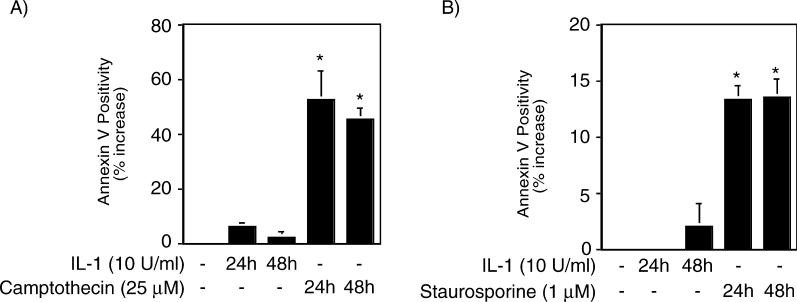
Effects of IL-1 on Annexin V Staining in RINm5F Cells and Rat IsletsTreatment of RINm5F cells (A) or rat islet cells (B) with 10 units/ml IL-1 did not stimulate PS externalization, as determined by annexin V staining and quantified by flow cytometry. In contrast, treatment of RINm5F Cells with camptothecin (25 μM) (A) or rat islet cells with staurosporine (1 μM) (B) stimulated the externalization of PS. Results are presented as percent increase in annexin V-positive cells above the basal levels (∼3%–7%) detected on untreated control RINm5F or rat islet cells and are the average ± SEM of three independent experiments. *p < 0.05, significantly different from untreated control.